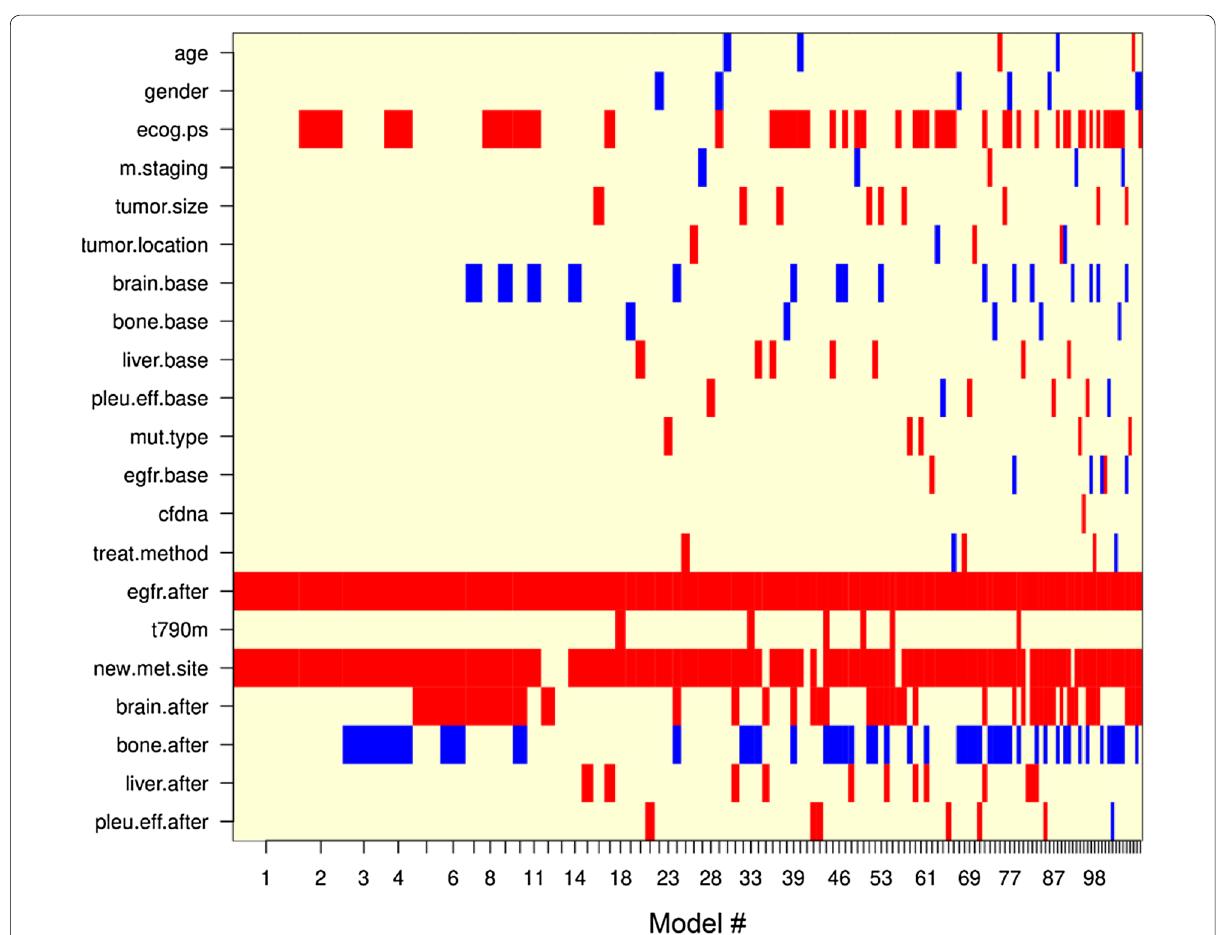
Fig. 4 The possibility that factors appear in prognostic models for PFS by the Bayesian Model Averaging method. EGFR mutations in post‑treatment plasma (egfr.after) and new metastasis (new.met.site) factors present in most models (100% and 95%,